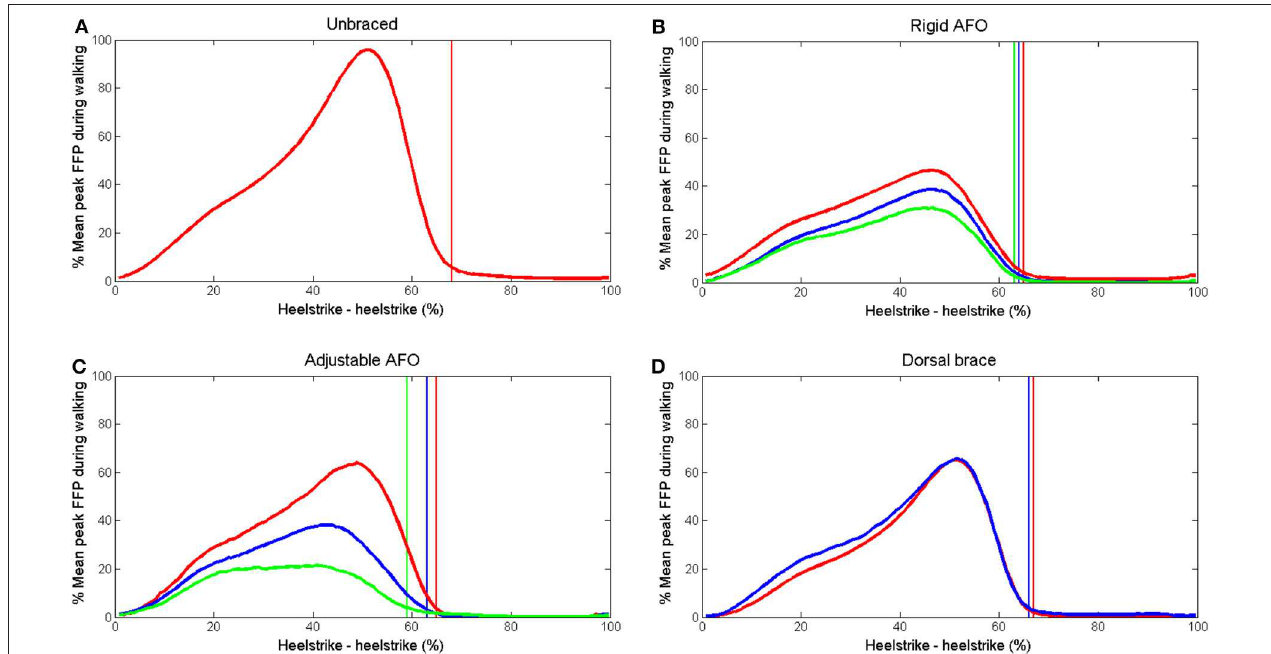
FIGURE 5 | Mean forefoot pressure during walking. (A) unbraced walking (B) rigid AFO with 0 wedges (red), 2 wedges (blue) and 3 wedges (green). (C) adjustable AFO with ankle dorsiflexion limited to 10 ◦ dorsiflexion (red), 10 ◦ plantarflexion (blue), and 30 ◦ plantarflexion (green) (D) dorsal brace with 0 wedges (red) and 1 wedge (blue). Toe off time is indicated for each setting by a vertical line in the corresponding